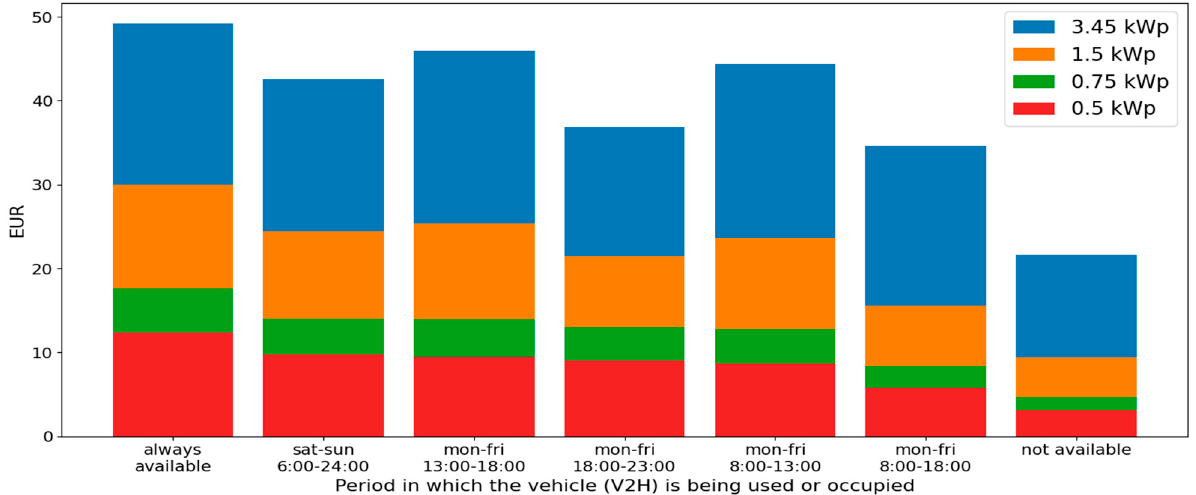
Figure 7. Average savings with injection (per month).